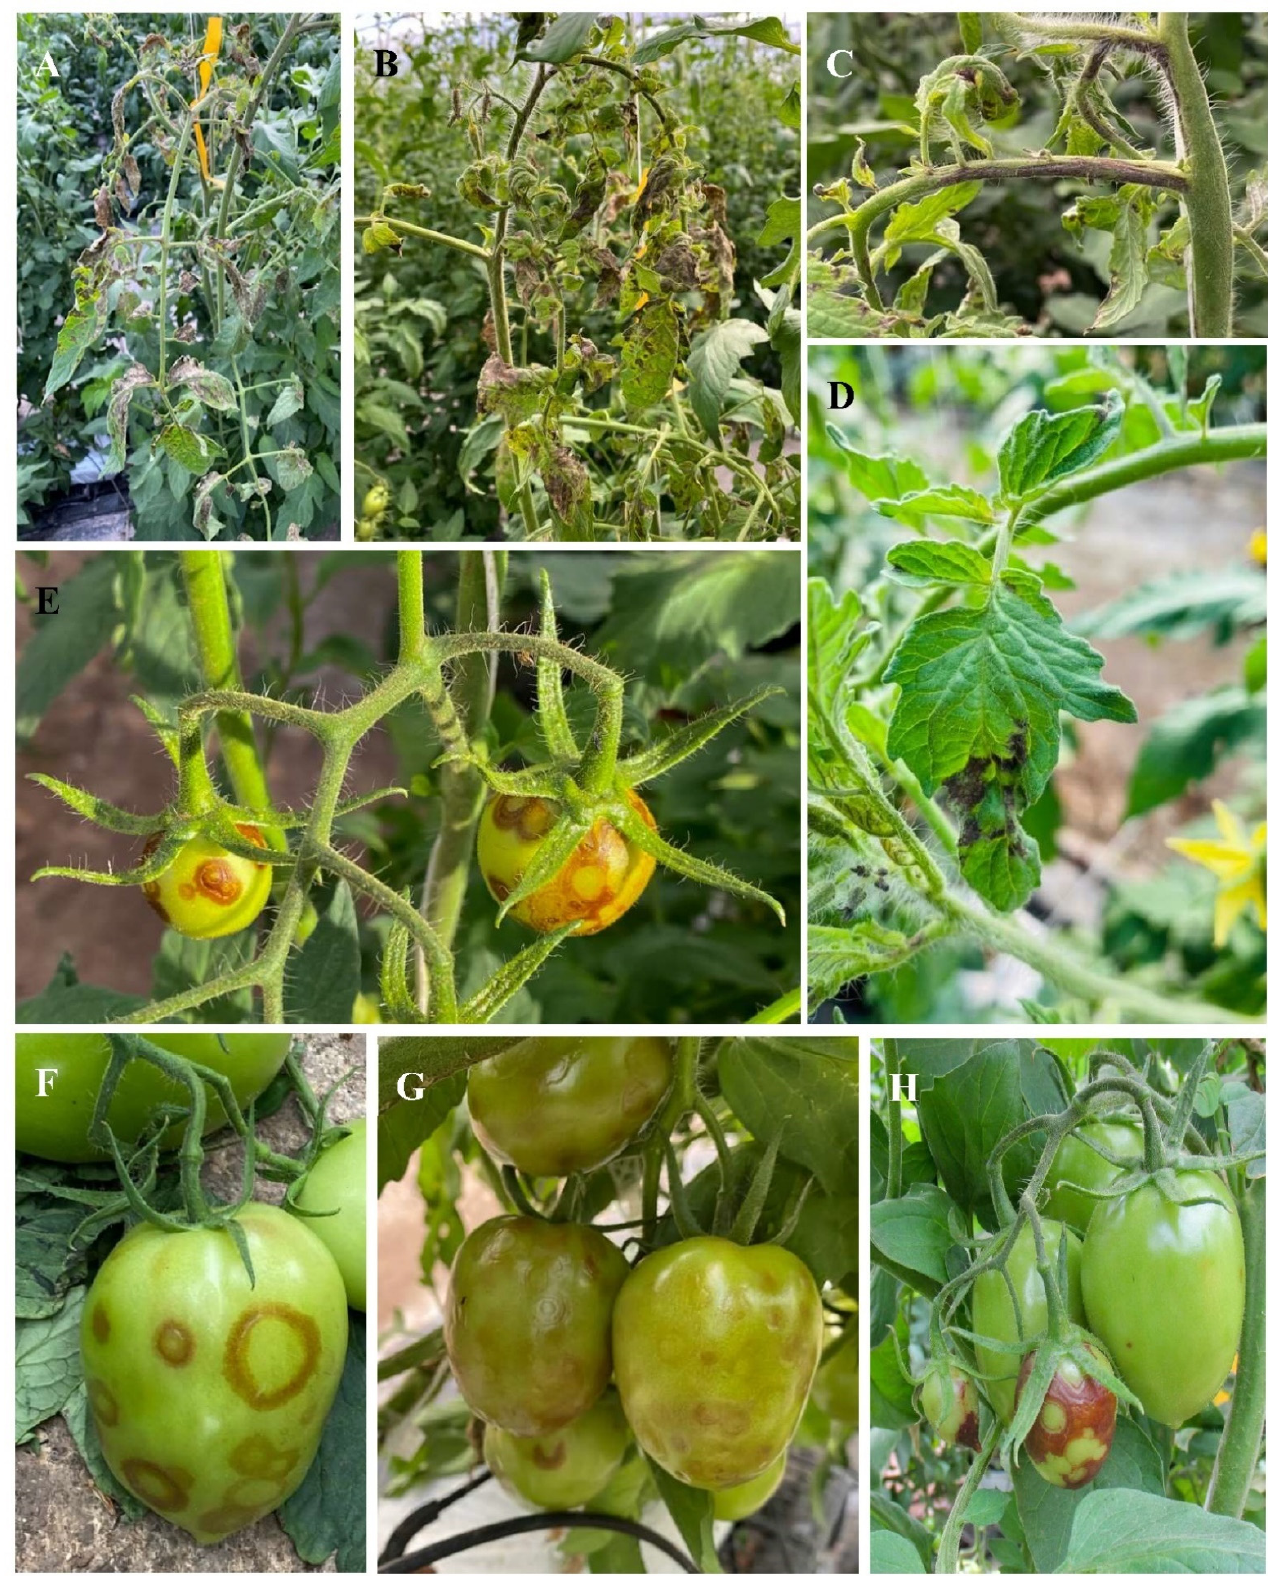
Figure 2. Symptoms caused by tomato spotted wilt virus on tomato plants. ( A – D ) Necrosis in stems, leaves, and flowers. ( E – H ) Fruits with concentric and necrotic rings.